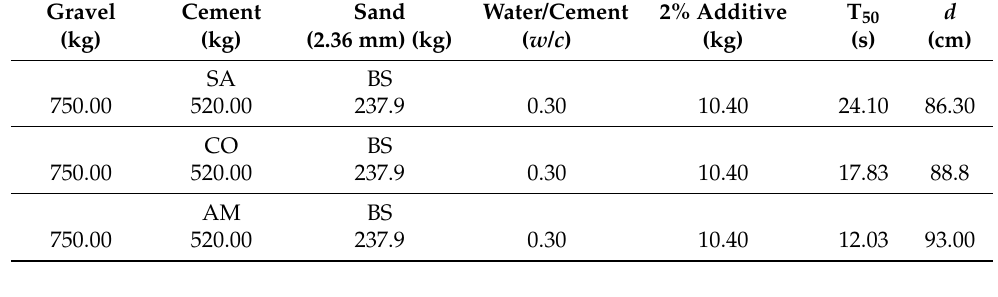
Table 12. Concrete formulations inferred from F3-CEMs (Table 11) and the recommendations by Colegio Oficial de Ingenieros Civiles (Quito, Ecuador) (Table 3).